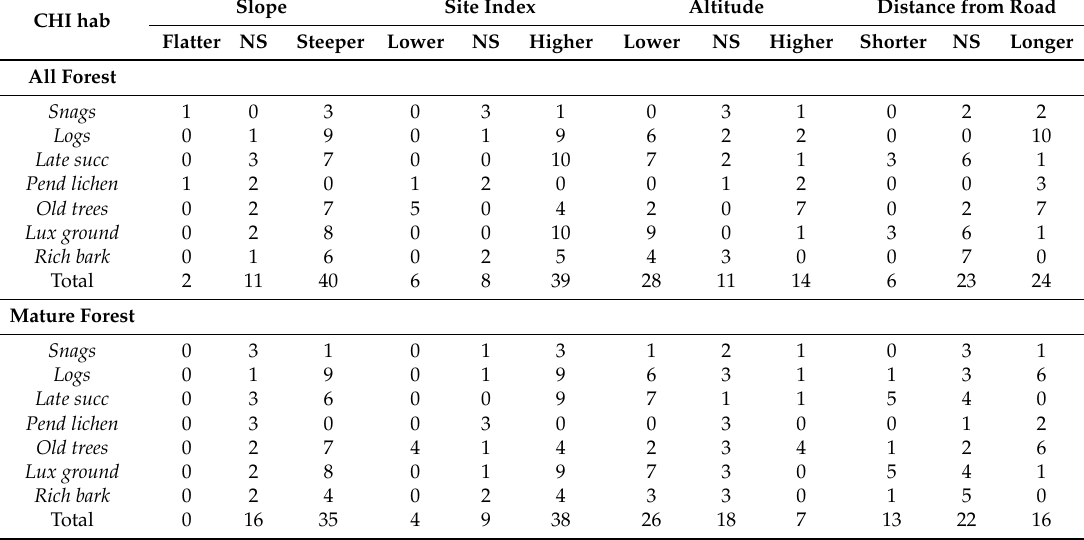
Table 4. Differences in the distribution of CHI habitats compared to all forest and all mature forest, respectively, for the variables slope, site index, altitude, and distance from road. The numbers refer to the number of municipalities with statistically significant outcomes ( p < 0.05), and those not significantly different (NS) from random expectation (see Supplementary material for Bayesian tests for each municipality and habitat type). The number of outcomes varies between habitat types because not all habitats were found in all municipalities. Late succ = Late succession of deciduous trees , Pend lichen = Pendant lichens , Lux ground = Luxuriant ground vegetation , Rich bark = Trees with nutrient-rich bark. Slope Site CHI hab